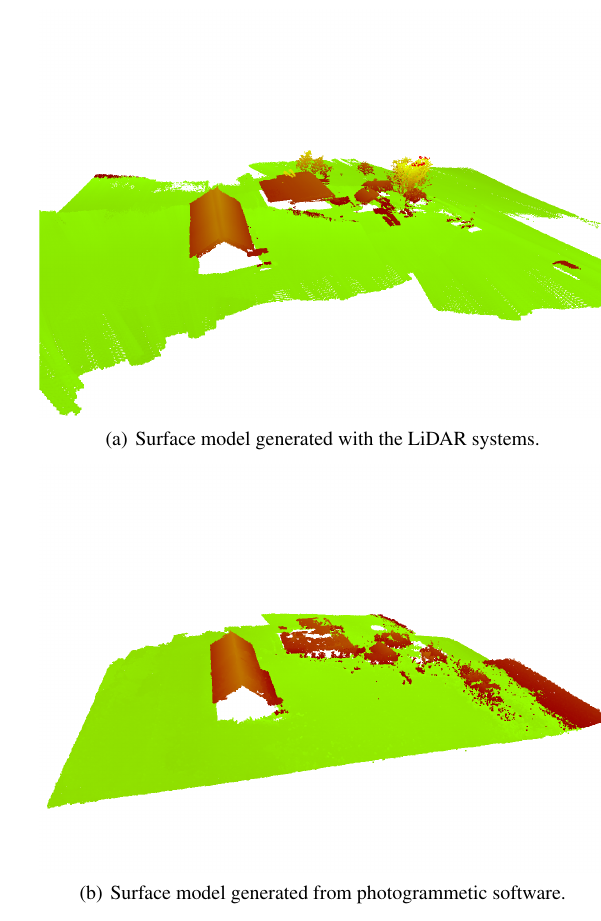
Figure 5: Digital surface model of the